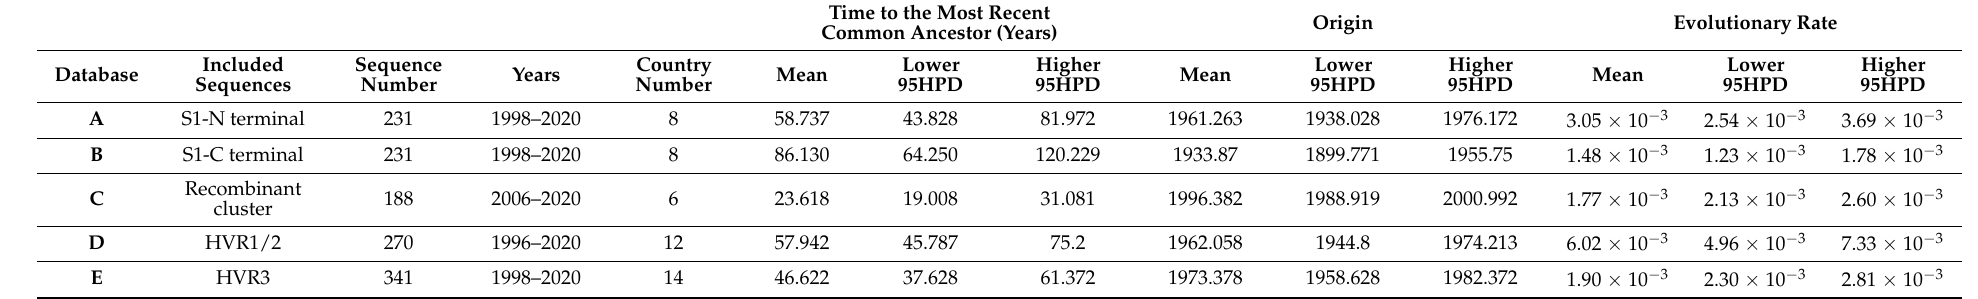
Table 1. Summary of the main dataset features and estimates of the population parameters reported as mean, 95% lower, and higher posterior density